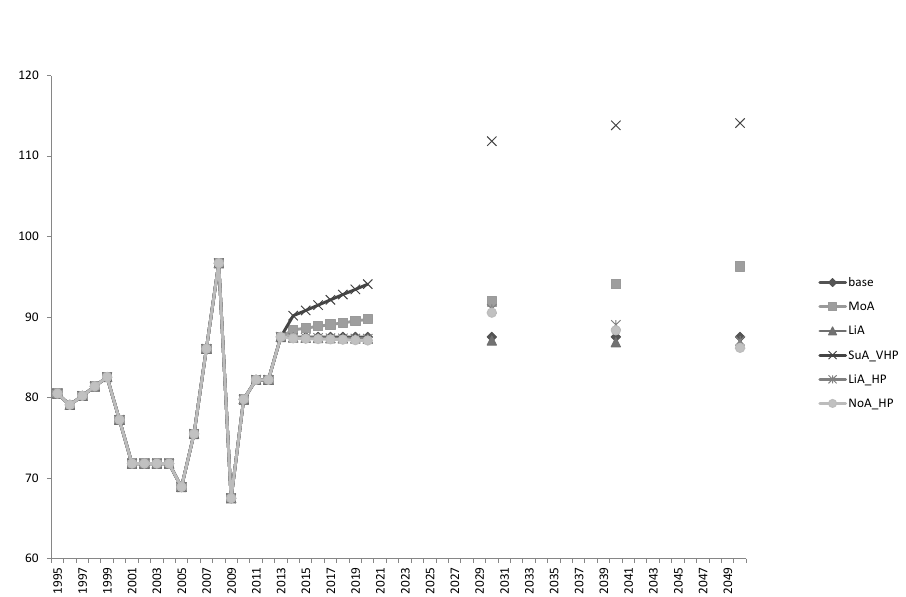
Fig. 2. Nitrogen fertilisation for barley (kg N ha -1 ) in different scenarios, southern Finland, support region B. Base = Baseline; MoA = Moderate adaptation (yields +10%); LiA = Little adaptation (yields –10%); SuA_VHP = Successful adaptation, very high prices (yields +30%, crop prices+30%); LiA_HP = Little Adaptation, high prices (yields –10%, crop prices +10%); NoA_HP = No adaptation, high prices (yields –20%, crop prices +10%)